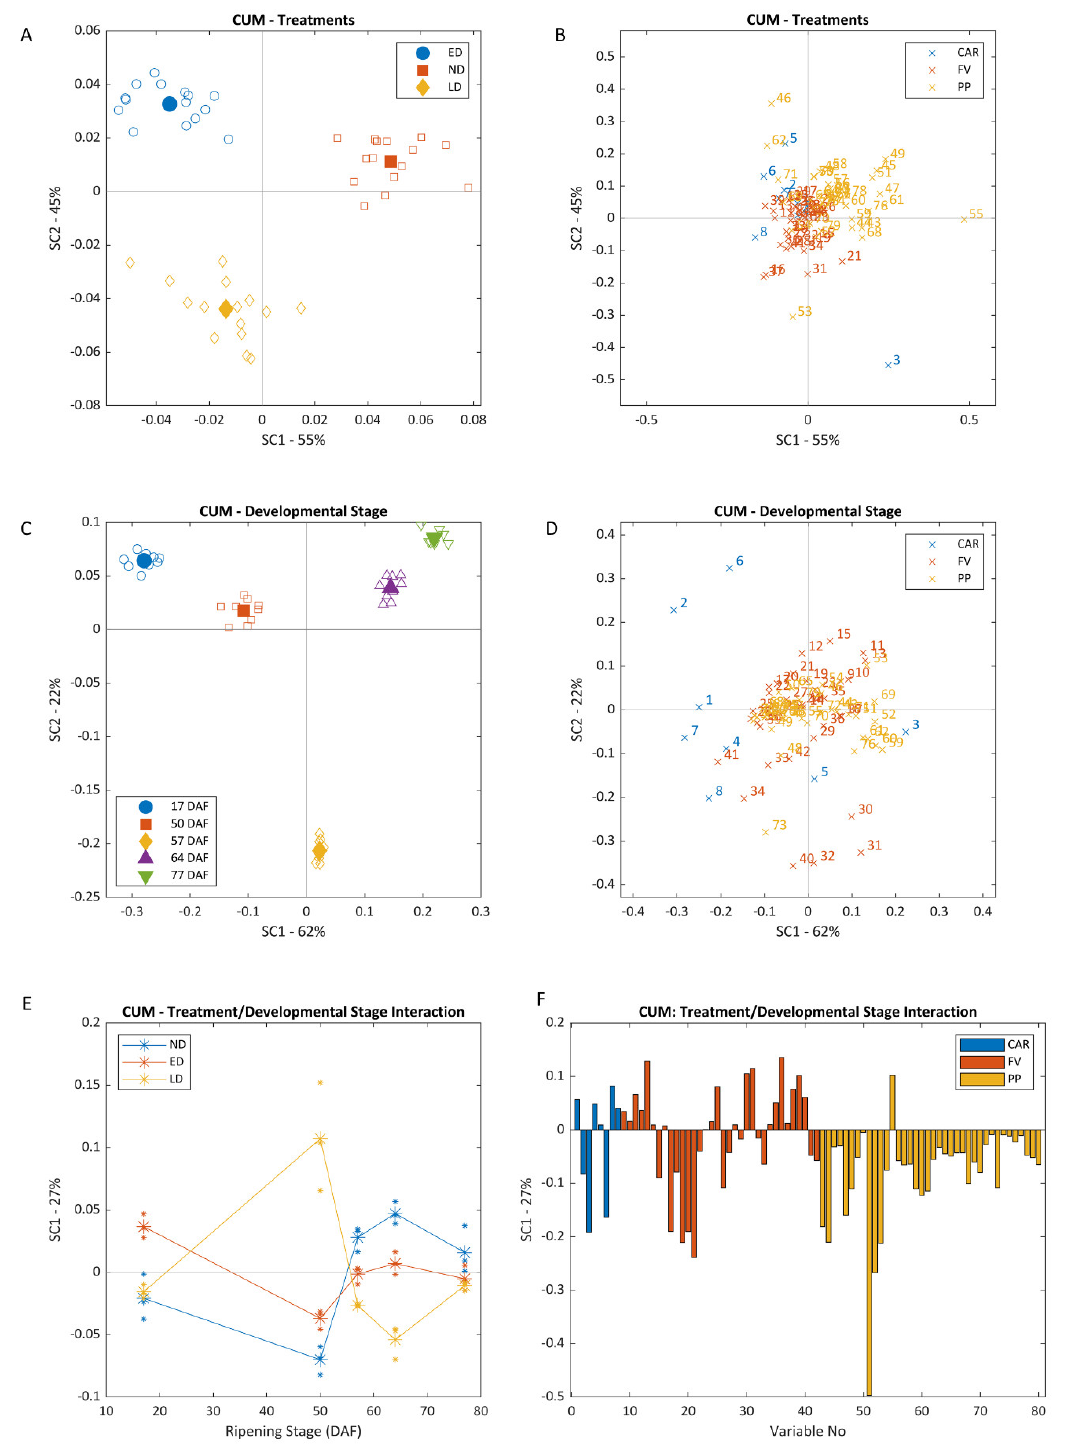
Figure 2. Scores ( A , C ) and loadings ( B , D ) ASCA plots for the first and second SC, and longitudinal scores ( E ) and loadings ( F ) plots for SC1, for CUM vineyard. Plots ( A , B ) correspond to factor Treatments, ( C , D ) to factor Developmental Stage and ( E , F ) to the model’s interaction term. List of variables used in loadings plots ( B , D , F ) can be found in Supplementary Table S5. SC stands for simultaneous component; ND, no defoliation; ED, early defoliation; LD, late defoliation; CAR, carotenoids; FV, free volatiles; PP, polyphenols; DAF, days after flowering. Filled symbols indicate group centroids ( A , C ).